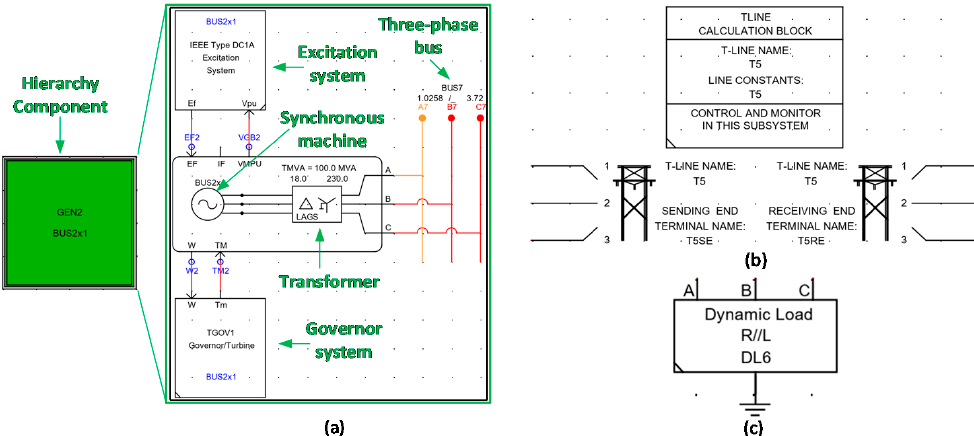
Figure 3. Modeling components used for constructing the transmission system in the real-time simulation testbed: ( a ) hierarchy component box for synchronous generator; ( b ) unified transmission line model; ( c ) dynamic load component.